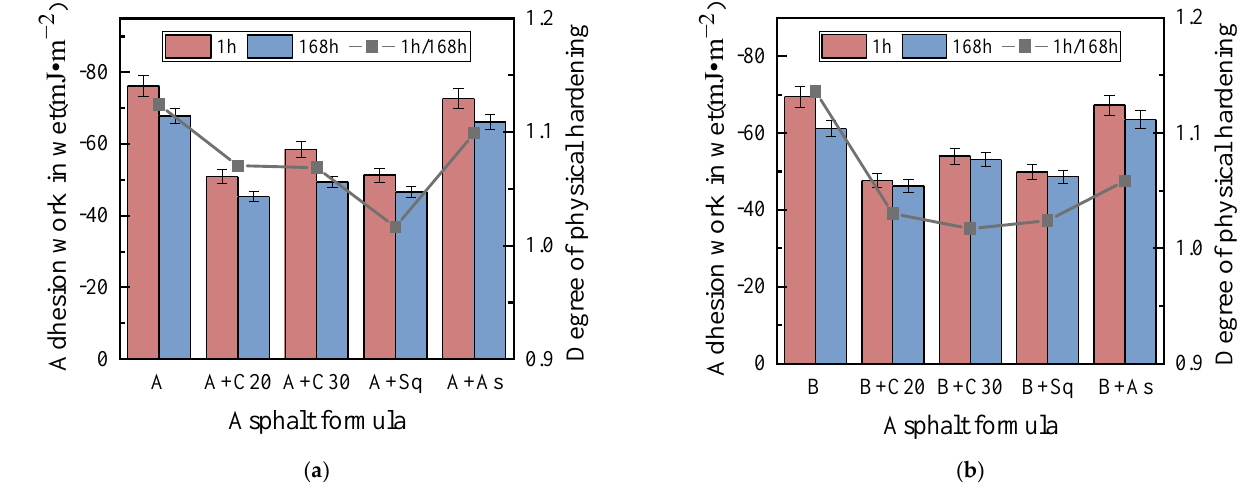
Figure 11. Adhesion work in wet conditions. ( a ) Asphalt A. ( b ) Asphalt B.